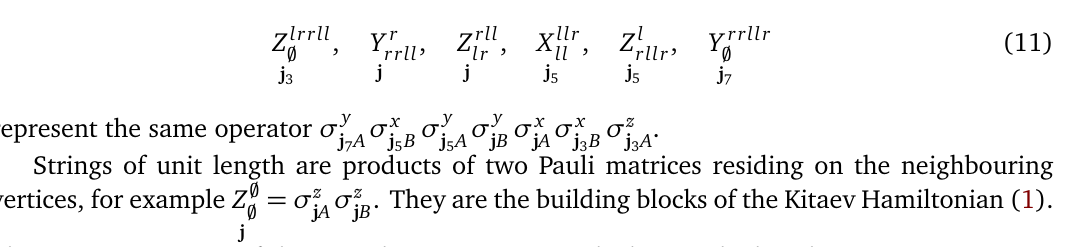
Figure 1: The string Z rll tices of sublattices A and B are shown as open and gray-filled circles, respectively. The X -, Y - and Z -links are shown in blue, green and red, respectively. The links belonging to the string are